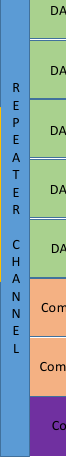
Table2: Flop Drive Strength for critical and non-critical signals